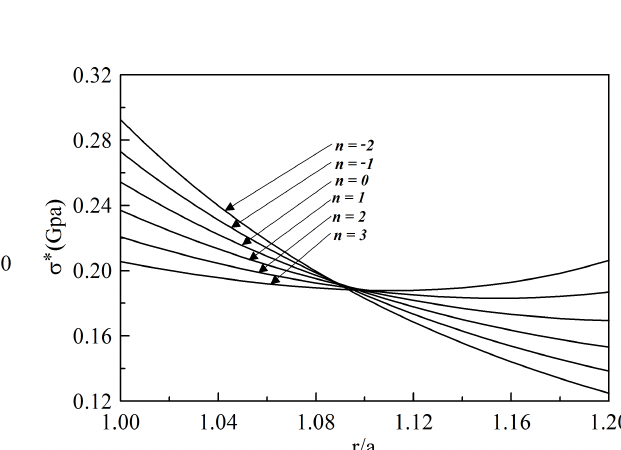
Figure 25: Radially distributed von-Mises